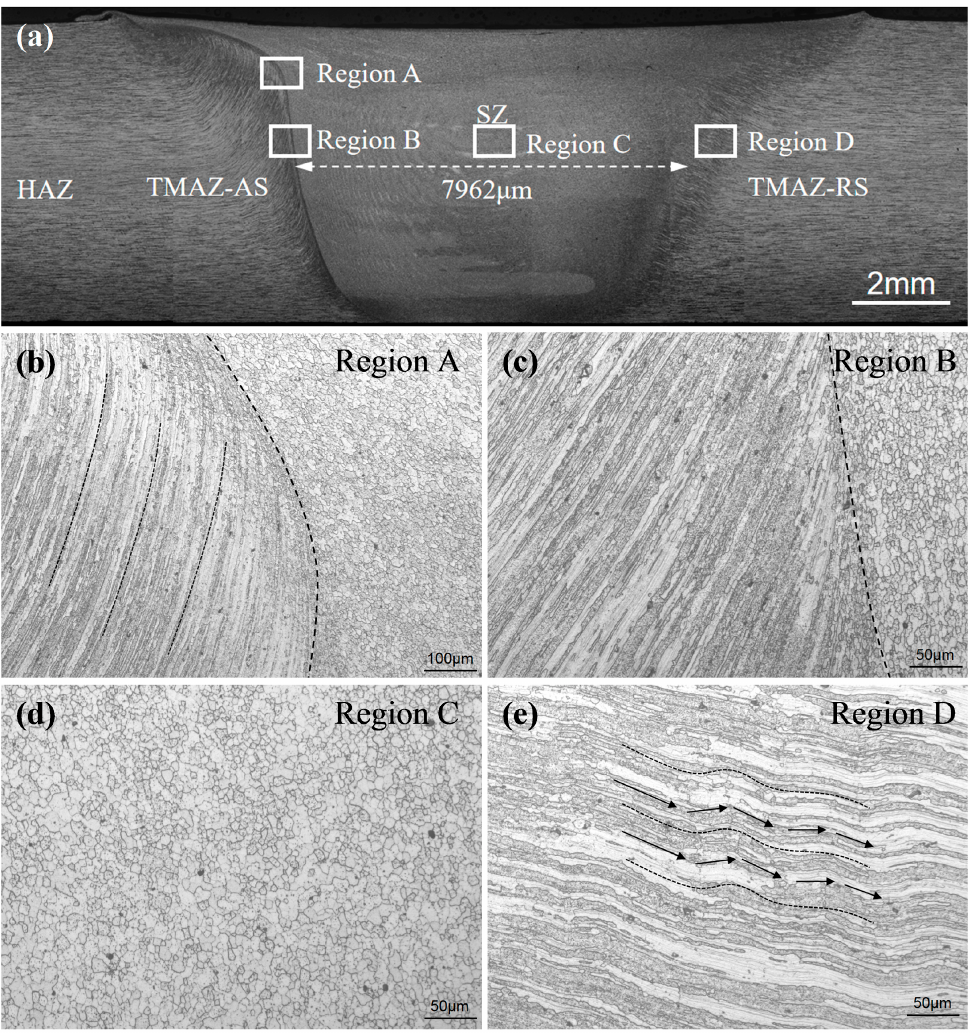
Figure 4. Macrostructure and microstructure of the UAFSW joint: ( a ) Macrostructure; ( b ) stirred zone/thermo-mechanically affected zone (SZ/TMAZ) junction; ( c ) thermo-mechanically affected zone (TMAZ) on the advancing side (TMAZ-AS); ( d ) SZ; and ( e ) TMAZ on the retreating side (TMAZ-RS).